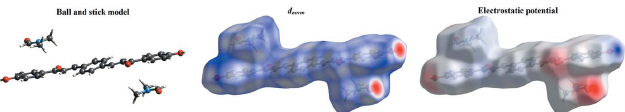
Figure 3 d norm and electrostatic potential mapped on Hirshfeld surfaces to visualize the intermolecular contacts in the title compound. The molecule in the ball-and-stick model is in the same orientation as for the Hirshfeld surface and electrostatic potential plots.